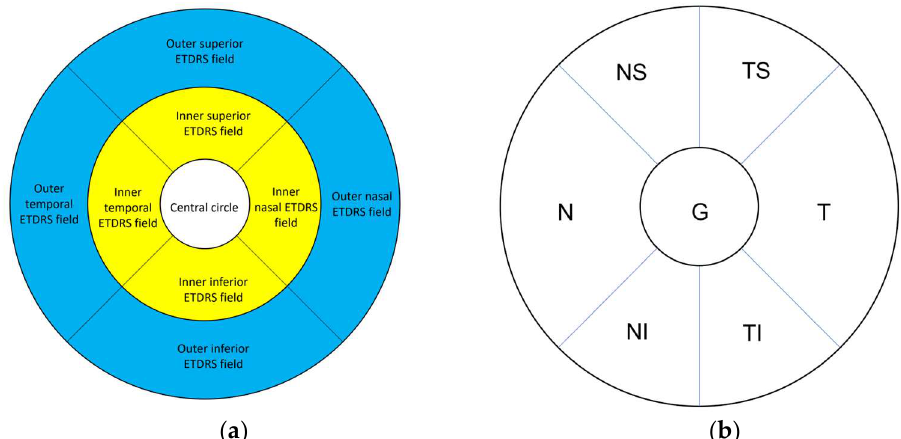
Figure 2. ( a ) ETDRS fields of the right eye. White: central circle. Yellow: Middle ETDRS ring consisting of inner nasal, inner superior, inner inferior, and inner temporal ETDRS field. Blue: Outer ETDRS ring consisting of outer nasal, outer superior, outer inferior, and outer temporal ETDRS field ( b ) Six sectors of the peripapillary RNFL thickness fields of the left eye: temporal superior (TS), temporal inferior (TI), temporal (T), nasal superior (NS), nasal inferior (NI) and nasal (N) fields) and the global 360° average value (G).